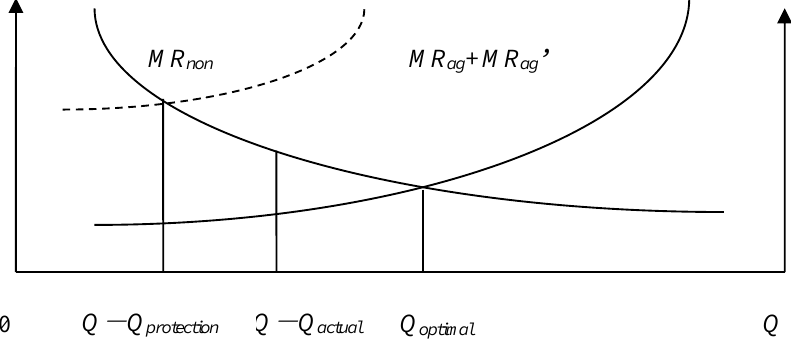
Figure 7. Allocation of county-level land resources under the seventh situation.